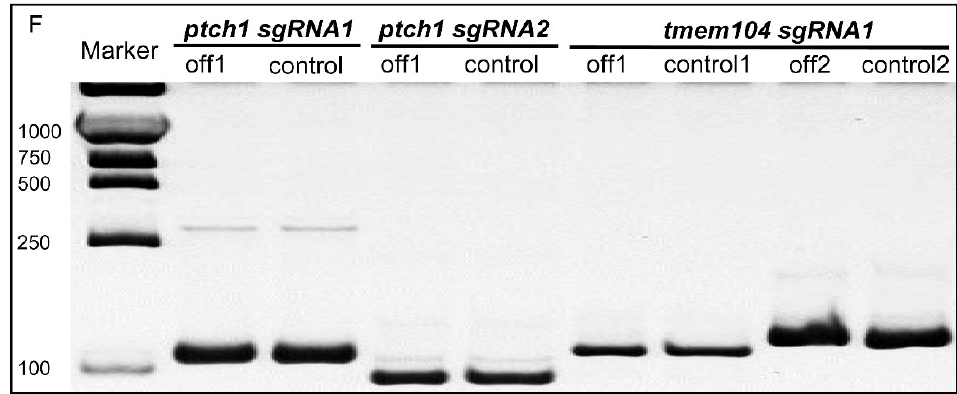
Figure 3. pCas9-mU6sgRNA efficiently edited the endogenous genes ptch1 , ptch2 , tmem104 and sytl5 in medaka cultured cells. ( A – D ) HMA (heteroduplex mobility assay) of DNA templates extracted from SG3 cells transfected with pCas9-mU6sgRNA. pCas9-mU6sgRNA plasmids targeting four endogenous genes ptch1 ( A ), ptch2 ( B ), tmem104 ( C ) and sytl5 ( D ) were transfected into SG3 cells, respectively. After G418 selection for 7 days, the genomic DNA was extracted for PCR and then the amplicons were separated with PAGE, giving a main band of homoduplex and upper bands consisting of heteroduplex or homoduplex. Control lanes were amplicons of genomic DNA from wild-type SG3 cells. Boxed areas indicate the heteroduplex or homoduplex DNA bands in amplicons from pCas9-mU6sgRNA transfected SG3. ( E ) TIDE (Tracking of Indels by Decomposi-